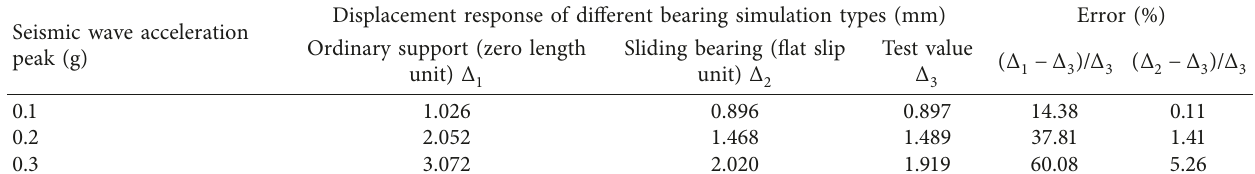
Table 6: Main beam displacement response result.